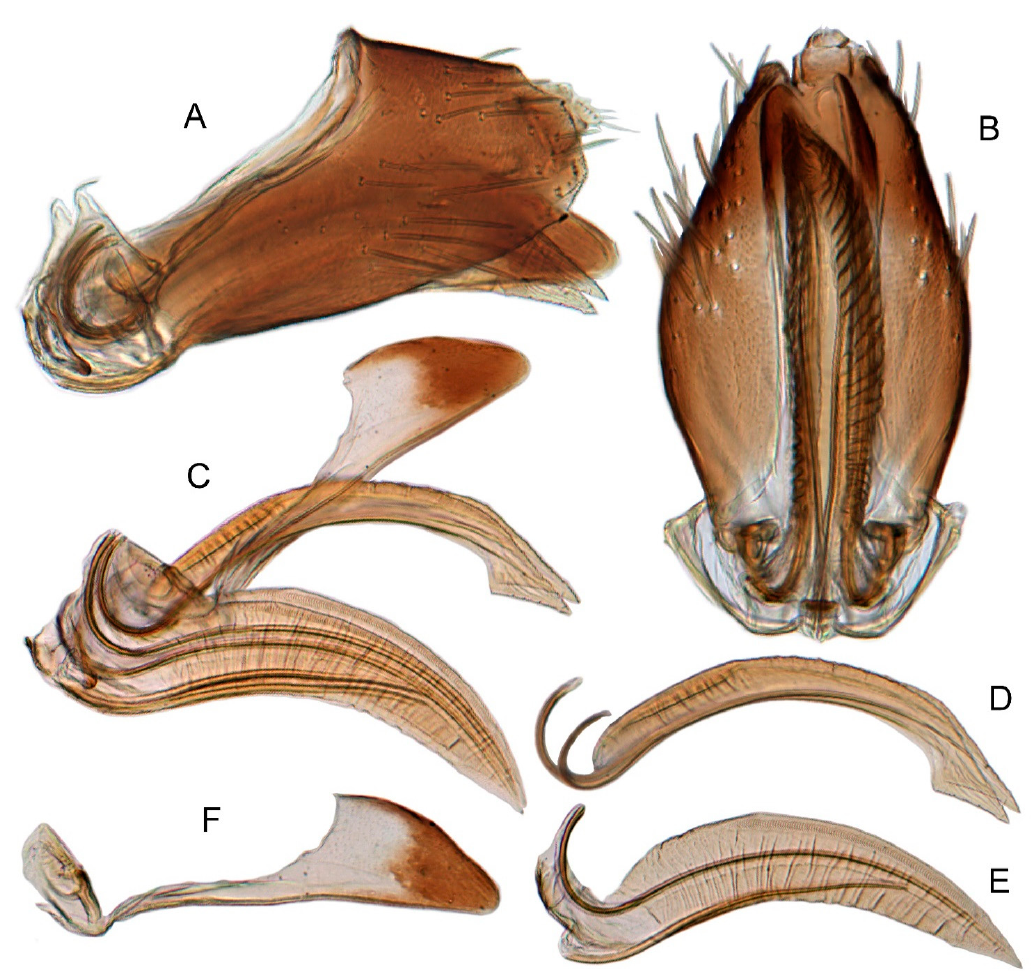
Figure 16. Xestocephalus exproiecturus sp. nov. ( A ) Female pygofer, lateral view; ( B ) female pygofer, ventral view; ( C ) ovipositor of female, lateral view; ( D ) second valvulae of female ovipositor, lateral view; ( E ) first valvula of female ovipositor, lateral view; ( F ) third valvula of female ovipositor, lateral view.